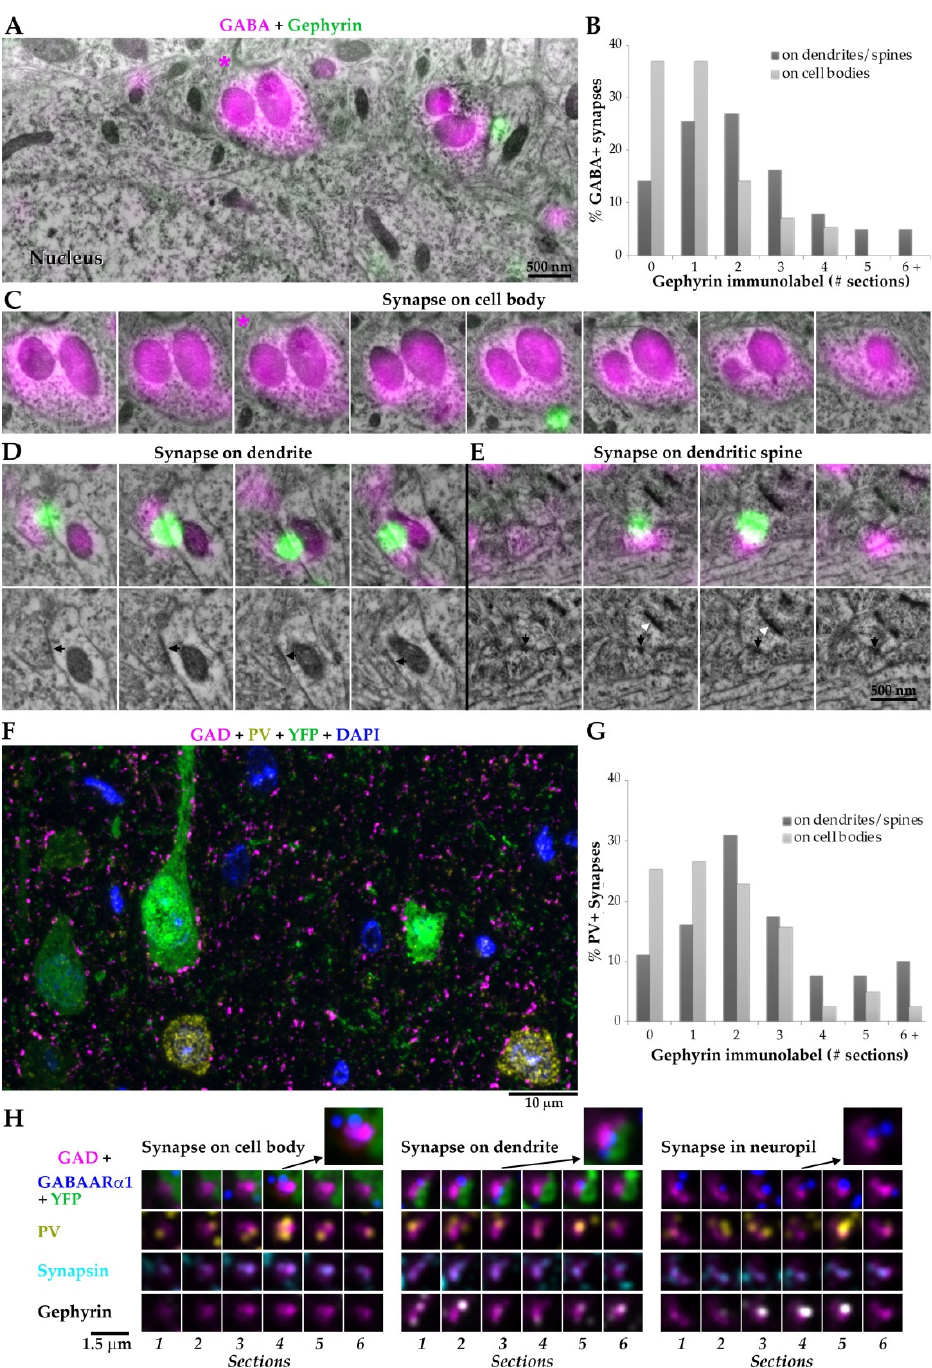
Figure 7. GABAergic synapses on Pyr somas have low gephyrin content. ( A ) Conjugate immunofluorescence—scanning electron micrographs (SEM) from adult mouse neocortex immunolabeled with GABA (magenta) and gephyrin (green). On this single section (70 nm), the GABA positive synapse onto the cell body (marked with asterisk) does not have postsynaptic gephyrin immunolabel, but the GABA+ synapse to the right that contacts a dendrite is gephyrin immunopositive; ( B ) gephyrin content of GABA positive synapses, depending on their target. Serial sections through the synapses were analyzed ( n = 57 on cell bodies, and n = 142 on dendrites and spines); ( C ) serial sections through the somatic synapse in A, marked with asterisk. Gephyrin immunolabel was present on only one section; ( D ) serial sections through a synapse targeting a dendrite. The second row shows the SEM images only, to show the synaptic contact (black arrow) that is obscured by the bright gephyrin-IF; ( E ) serial sections through a synapse on a dendritic spine. The same spine also receives a non-GABA excitatory synapse (white arrowhead). ( F ) Immunofluorescence of neocortical